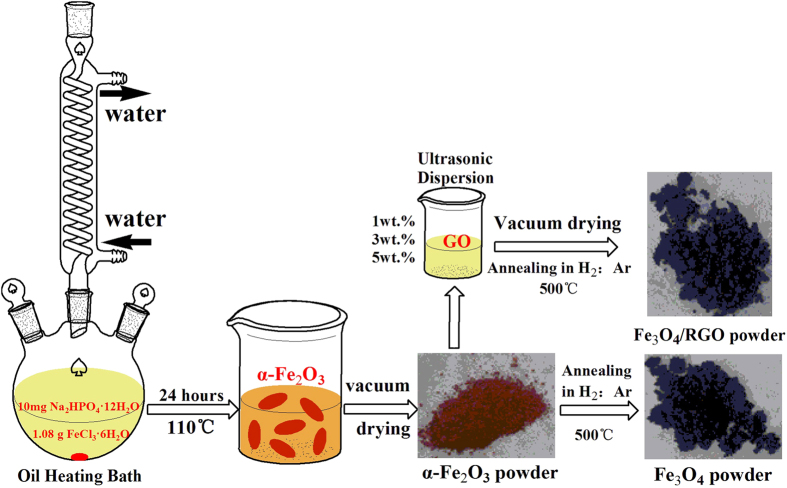
Illustration of the synthetic protocol for the Fe3O4/RGO nanocomposites.